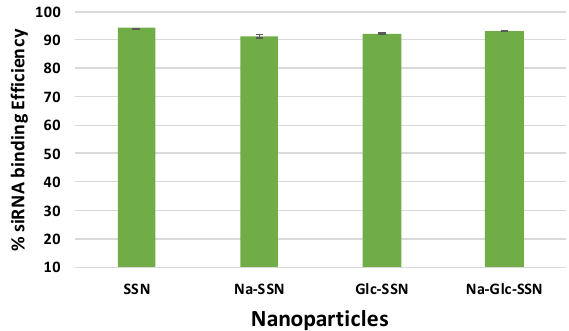
Figure 10. Binding efficiency of negative siRNA with differently formulated strontium sulfite particles formed by mixing SrCl 2 (60 mM) and Na 2 SO 3 (10 mM) along with 10 nM AF488 negative siRNA in the presence or absence of NaCl (300 mM) and glucose (200 mM).